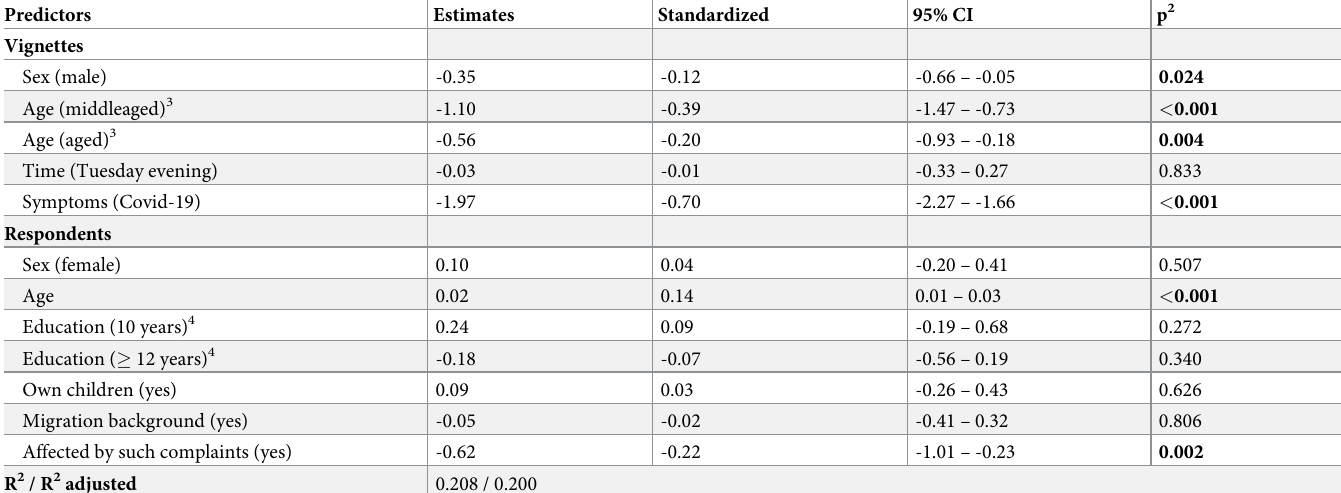
Table 3. Results of multiple regression analysis of perceptions of urgency of symptoms (N = 1,091) 1